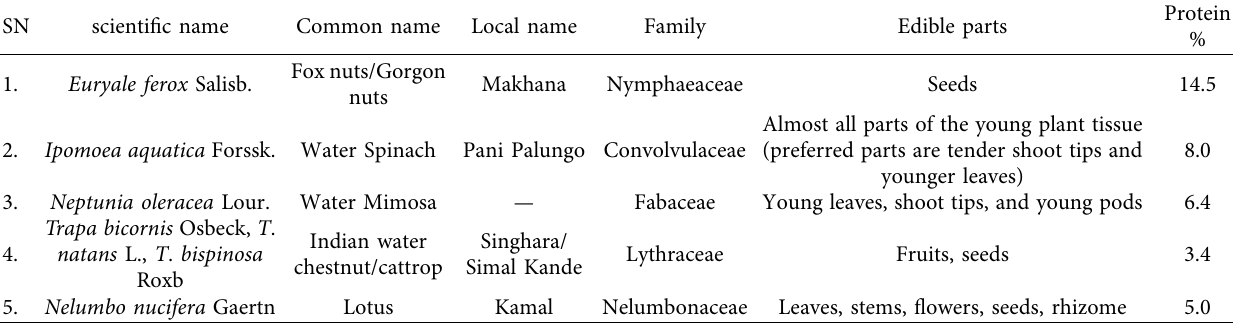
Table 9: Plants that can be promoted in the coming days by including them in aquaculture in Nepal.